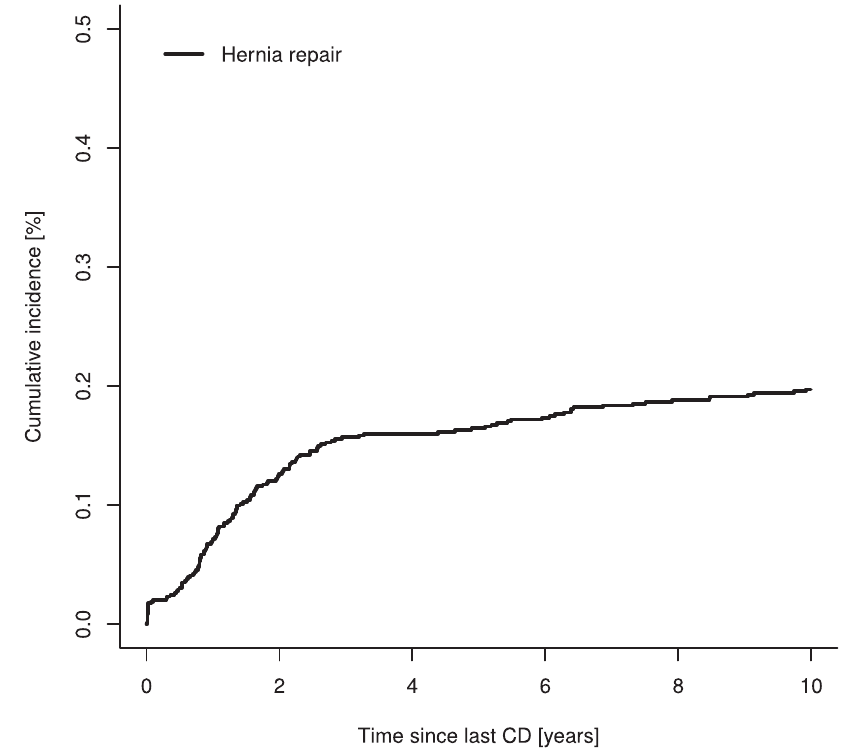
Figure 2. Cumulative incidence of incisional hernias requiring repair after cesarean delivery. CD: cesarean delivery.